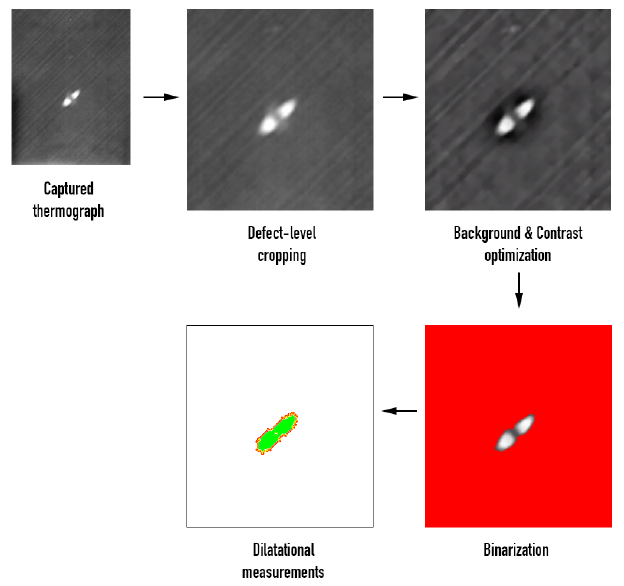
Figure 10. Image analysis processes for calculation of damage dimensions and area. Figure 9. Image analysis processes for calculation of damage dimensions and area.